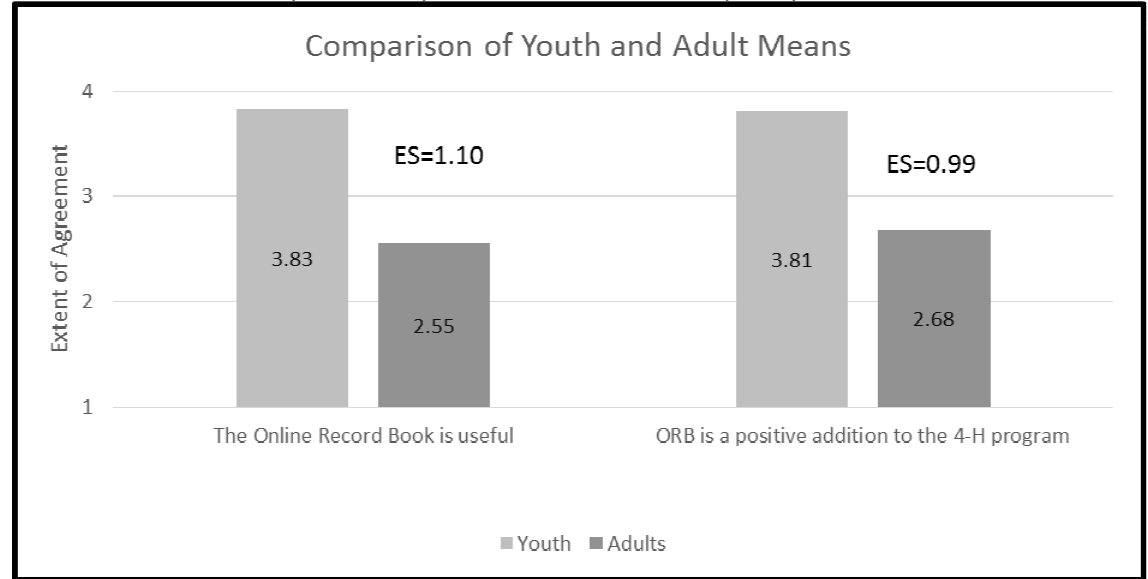
Comparison of youth and adult use and perceptions of